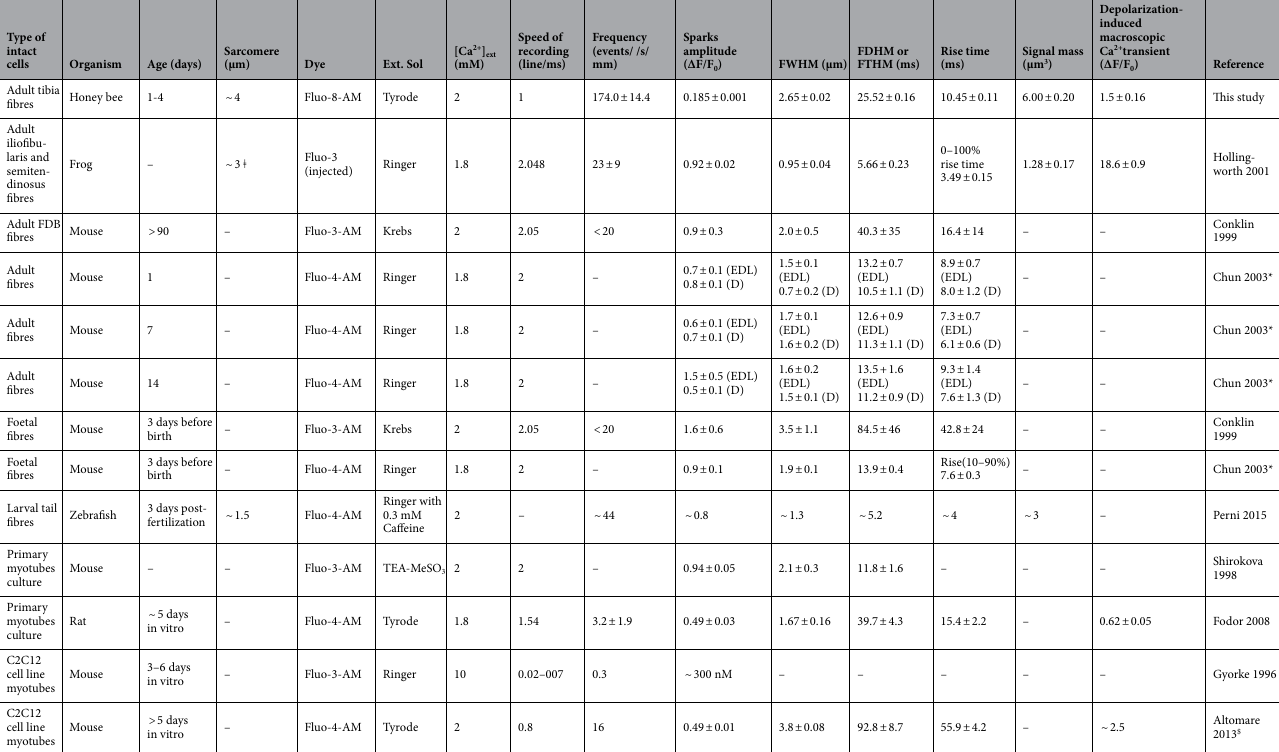
(with a crucial role attributed to the second RyR isoform) but it plays a null or minor role in rat fibres 47 . Despite a demonstrated CICR in frog, CREs from frog fibres are narrower than CREs from mammalian fibres, both in intact cells (Table 3) or in permeabilized fibres 48 . In the two vertebrate species, CREs width is narrower than in bees, which is clearly in agreement with a more important role for CICR in insects. In half of adult bee leg muscle fibres, a low-voltage-activated (LVA) current has been identified in addition to the nifedipine-sensitive high-voltage activated (HVA) current 5,49 . Both HVA- and LVA- calcium currents exists in mammalian fibres as well, but the density of the later gradually decreases postnatally to eventually disappear after 2–3 weeks of age 50 . Whereas DHPRs responsible for the HVA- (L-type) current are involved in triggering and/or repressing sparks in immature and adult mammalian muscle fibres 27,32 , pharmacological proofs indicate that the LVA- (T-type) calcium channel doesn’t modulate sparks frequency 32 . A role for the LVA- current in the genesis or regulation of honey bee CREs thus remains to be studied. Amplitude of honey bee sparks measured in XYT experiments appeared smaller than in almost all other intact preparations (Table 2, 3). This parameter is however highly subjected to the experimental set-up performances, imaging analysis and thresholding strategies, as illustrated in XT experiments from frog, where amplitude can vary by a factor 5 (Table 3). Namely, using the traditional threshold-based sparks detection method, the former study of sparks in intact frog fibres described an average amplitude of ~ 1 ΔF/F 023 , whereas a recent publication using the wavelet detection method described an average amplitude of ~ 0.2 ΔF/F 022 . The difference may be in part attributed to the more efficient detection of CREs of low amplitude with the wavelet method, but other fac- tors may be involved because the maximal amplitudes detected in the later publication reached ~ 0.85 ΔF/F 022 . Interestingly, in intact muscle fibres from a mouse model of myopathy ( mdx ), a similar analysis strategy (‘à trous implementation of the two-dimensional undecimated discrete wavelet transform’) led to the detection of CREs up to 1.3 ΔF/F 0 , with a half cumulative frequency value (CF 50 ) of 0.53 51 . The apparently low amplitude of honey